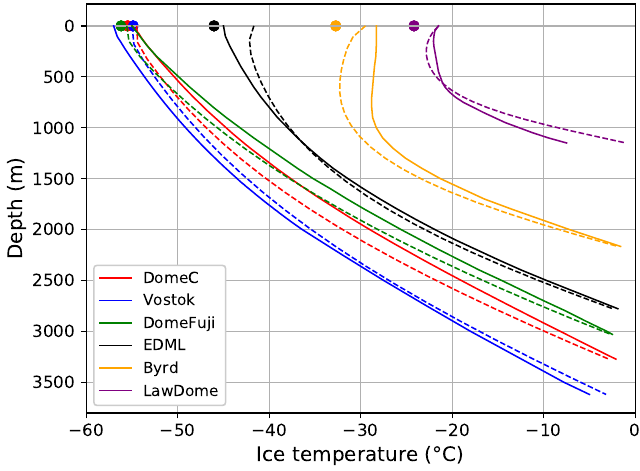
Figure 3. Borehole temperature profiles at several drilling sites in Antarctica from in situ measurements (solid line) and GRISLI (dashed line). The circles drawn at the surface indicate the value of the SMOS T B for each site (the red point is partly hidden by the blue and green